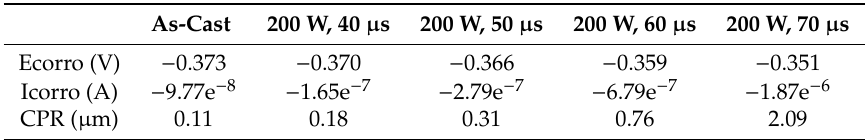
Table 4. Corrosion potential and corrosion current density of as-cast specimen and SLM specimens with parameters of P = 200 W, t = 40, 50, 60, and 70 µ